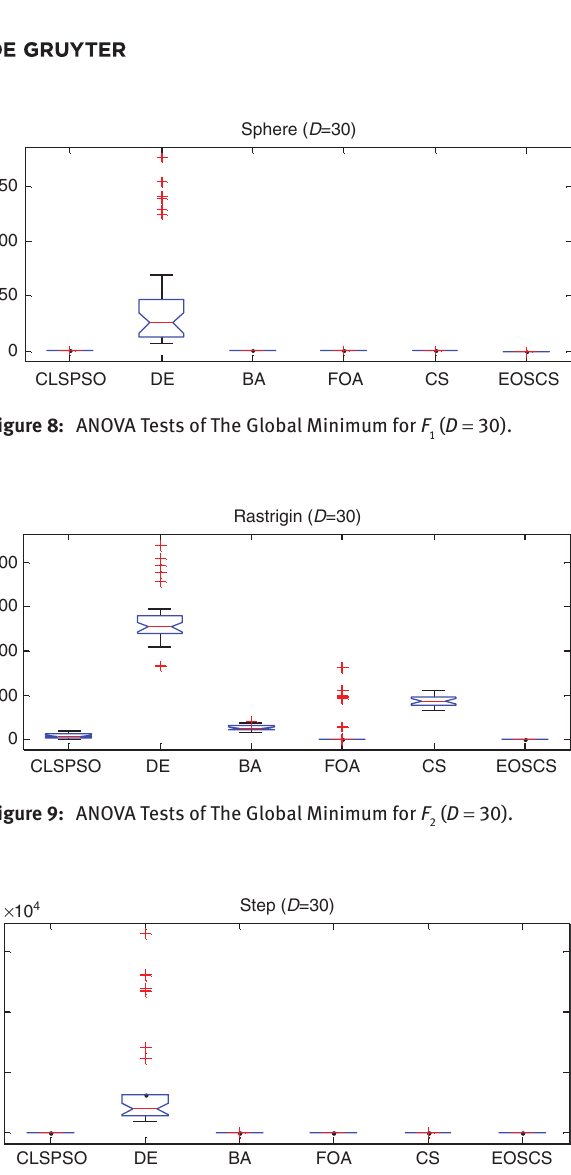
Figure 10: ANOVA Tests of The Global Minimum for F